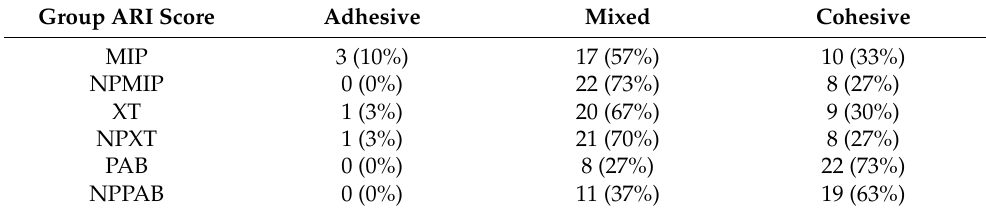
Figure 3. The frequency of adhesive remnant index (ARI) score number. Table 2. The frequency of adhesive failure (AF) scores, number, and percentage in the groups (n = 30/group). Group ARI Score